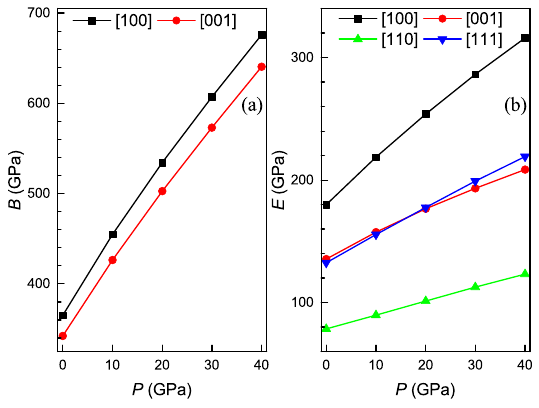
Figure 8. Directional bulk modulus ( a ) and Young’s modulus ( b ) along principle crystallographic axes as a function of pressure for the Ti 4 Nb 3 Al 9